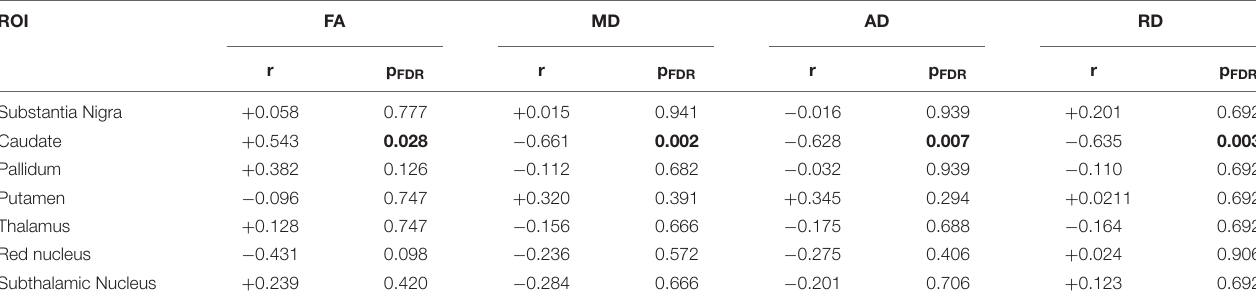
TABLE 3 | Spearman’s correlation between local CBF and diffusion parameters in PD group ( n = 26) within all the ROIs. ROI FA MD